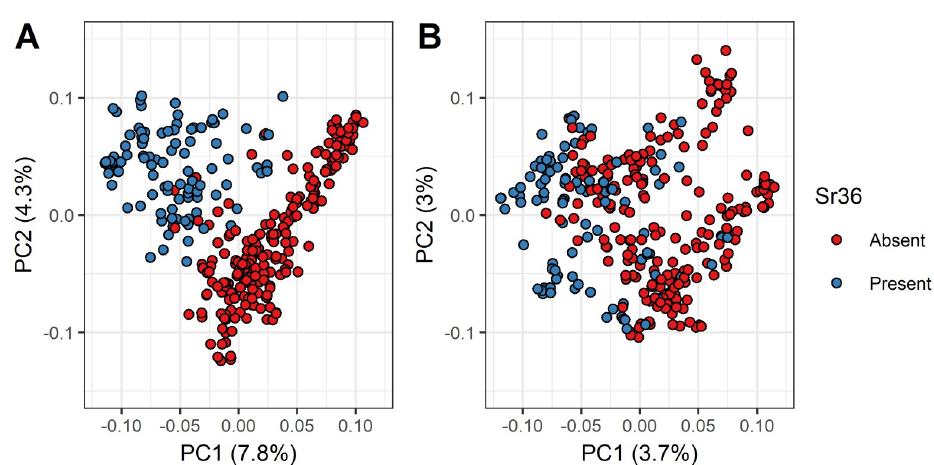
Fig 1. Biplots of genotypic principal components. The first and second principal components of the SNP matrix were plotted against each other, using (A) all SNPs that passed initial filtering parameters, and (B) a thinned subset of SNPs selected to be in approximate linkage equilibrium, so that no pair of SNPs displayed significant LD (r 2 > 0.2). The percent of the total genotypic variance explained is listed on each axis. Genotypes are divided into two groups based on the presence of absence of the Sr36 stem rust resistance gene and underlying 2G:2B translocation as determined by KASP assay.